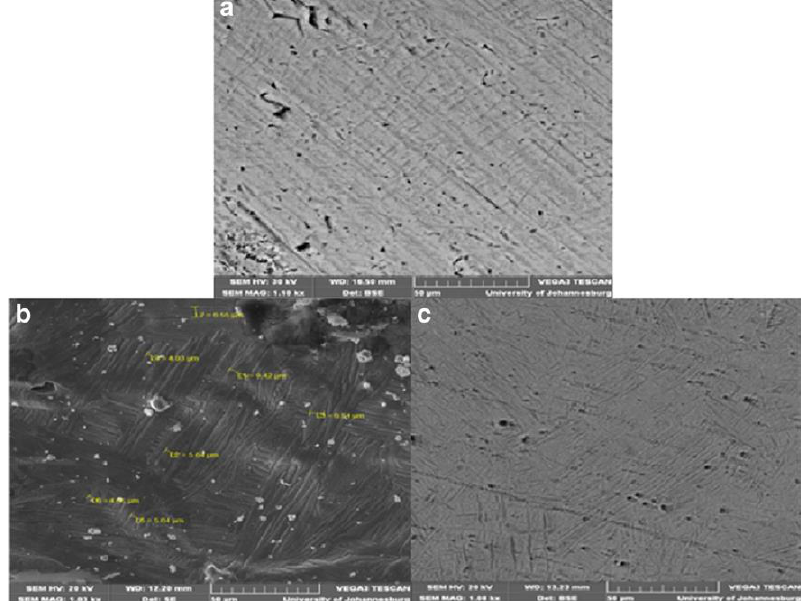
Figure 16. Microstructures of ( a ) sintered VB, ( b ) HT 1-VB and ( c ) HT 2-VB. Reproduced from [58], with permission from Springer Nature, 2017.